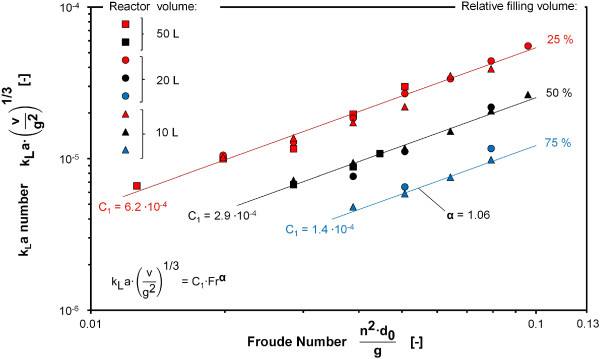
kLa number as a function of the Froude number for 10 L, 20 L and 50 L bioreactors at 25°C, kLa values determined with RAMOS using 1 M Na2SO3 solution with 10-7M CoSO4, 0.012 M phosphate buffer, initial pH = 8, power functions with average exponent α = 1.06 fitted to values for relative filling volumes of 25%, 50% and 75% at shaking frequencies of 80–220 rpm with n < NCaccording to Eq.2.